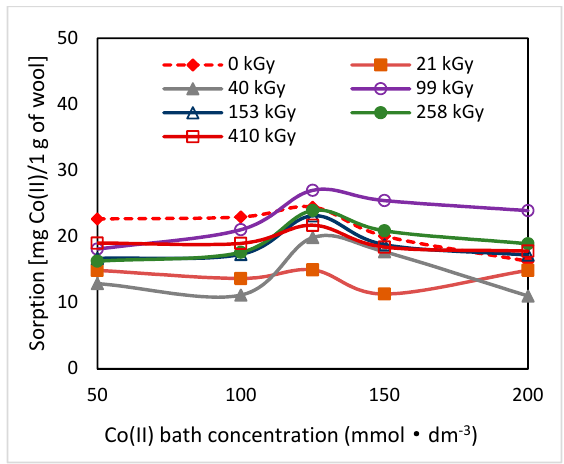
Figure 1. Variation of sorption of Co(II) on the wool samples depending on the initial bath concentration measured 2 days after the irradiation.